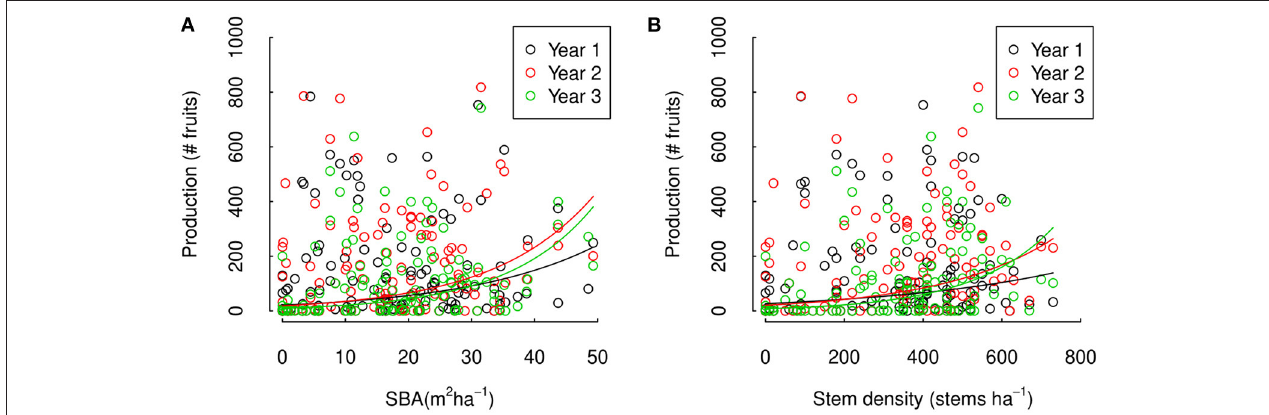
FIGURE 5 | Three years Brazil nut tree fruit production across a (A) SBA and (B) stem density gradient in the Tambopata National Reserve and its buffer zone in Madre de Dios, Amazonian Peru. The data points represent fruit counts of individual Brazil nut trees in our study sites, compared to the SBA and stem density in a 50m radius around the corresponding Brazil nut tree. The lines are model estimations obtained with mixed effect Poisson regression analysis for trees with average DBH and tree damage within our sites.